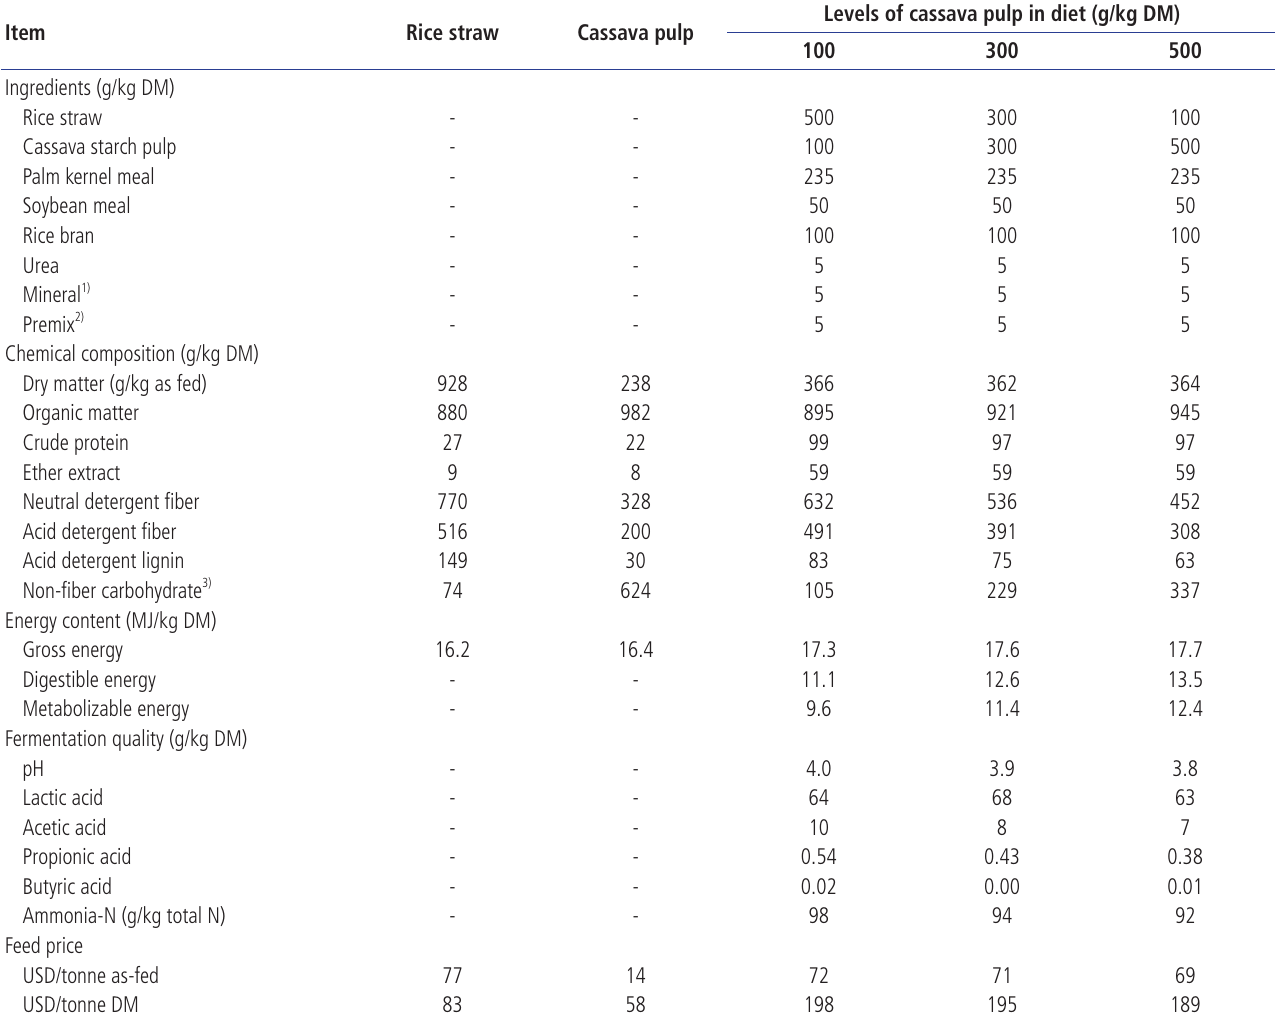
Table 1. Analyzed chemical composition of rice straw, cassava pulp and other feed ingredients; chemical composition, energy content, fermentation quality and feed price of the three fermented total mixed ration dietary